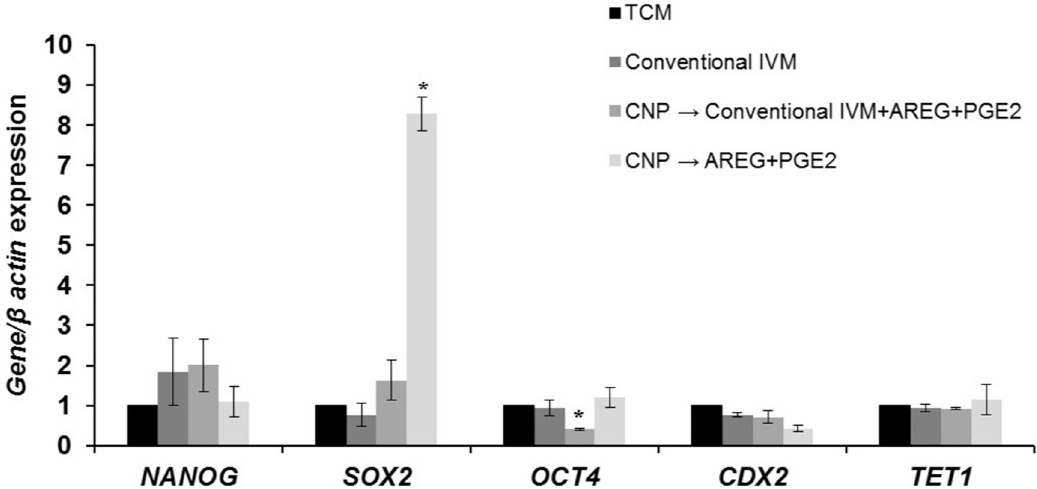
Fig 9. Assessment of relative expression of pluripotency and epigenetic markers in blastocysts derived from TCM, conventional IVM (24 h), [TCM+CNP (6 h), then cultured in TCM+AREG+PGE2 (18 h)] and [TCM+CNP (6 h), then cultured in conventional IVM supplements + AREG + PGE2 (18 h)] groups. 3 replicates and the minimum number of blastocysts in each replicate were 5. 2^ -(delta delta CT) was presented. The asterisks represent significant differences within columns with the same color. TCM: tissue culture medium, CNP: natriuretic peptide type C, AREG: amphiregulin, PGE2: prostaglandin E2.